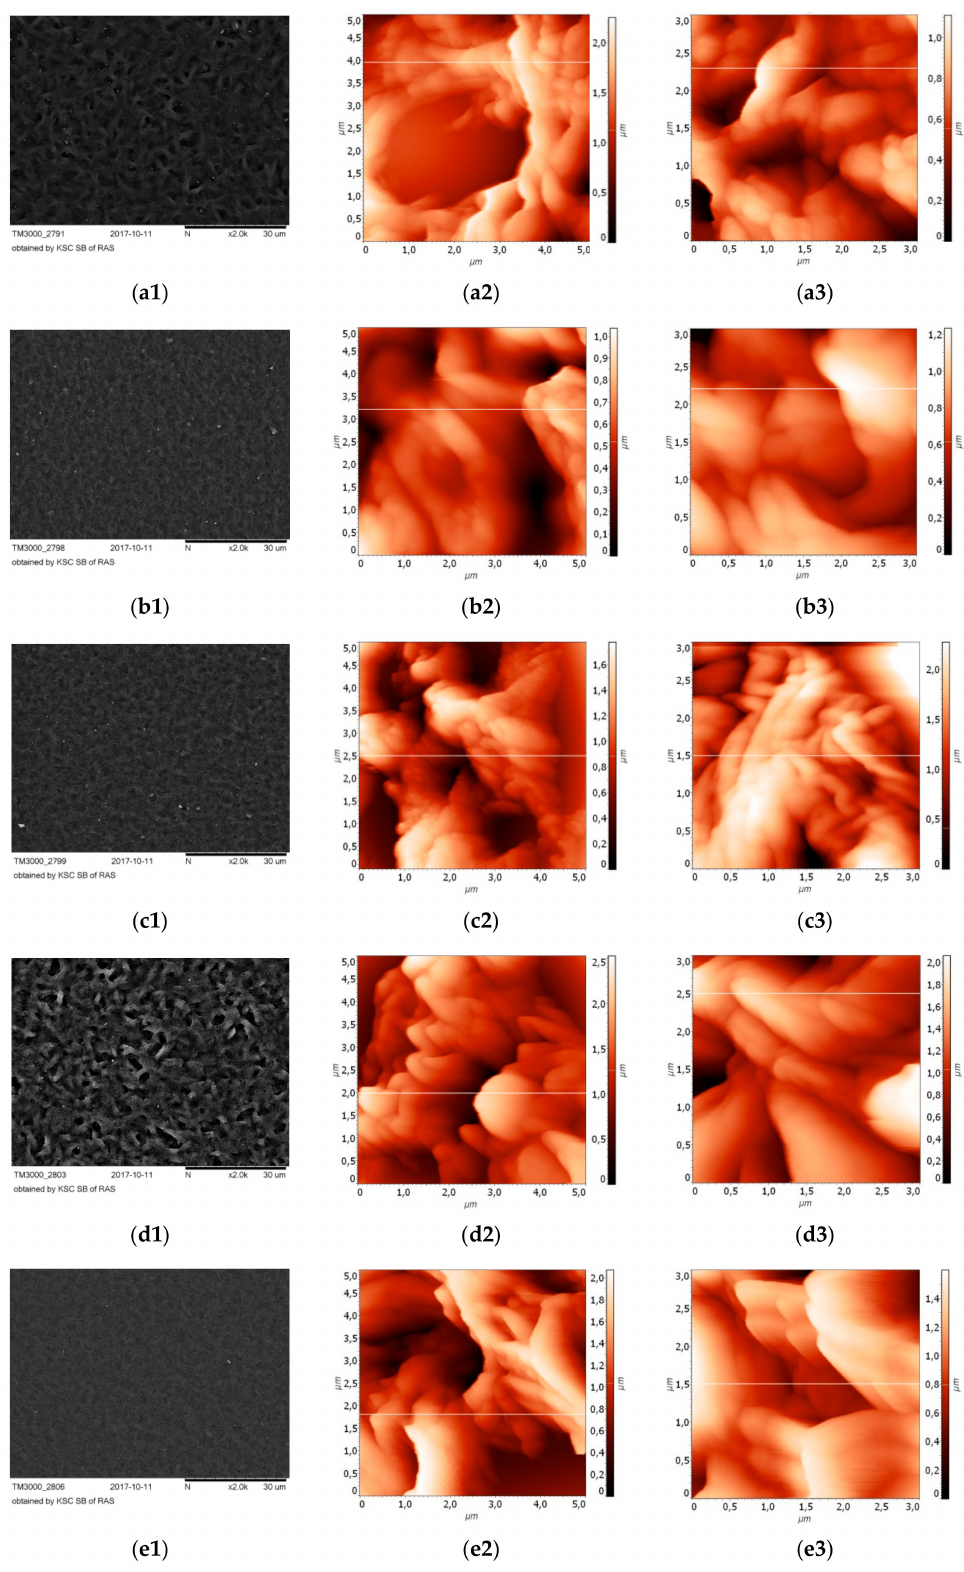
Figure 1. Surface topography of polyhydroxyalcanoates (PHA)bionanofilms. ( a1 – e1 )—surface topography of films 1–5, scanning microscopy; 3-D reconstructions of surface